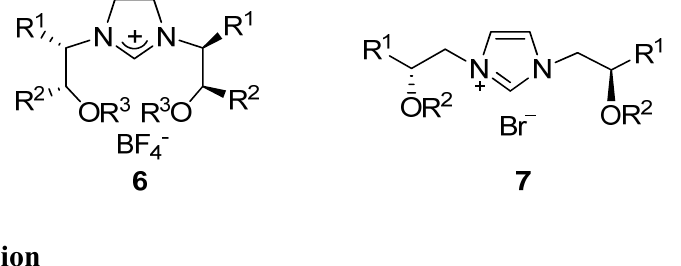
-symmetric imidazol(in)ium salts 6 and 7 . 2